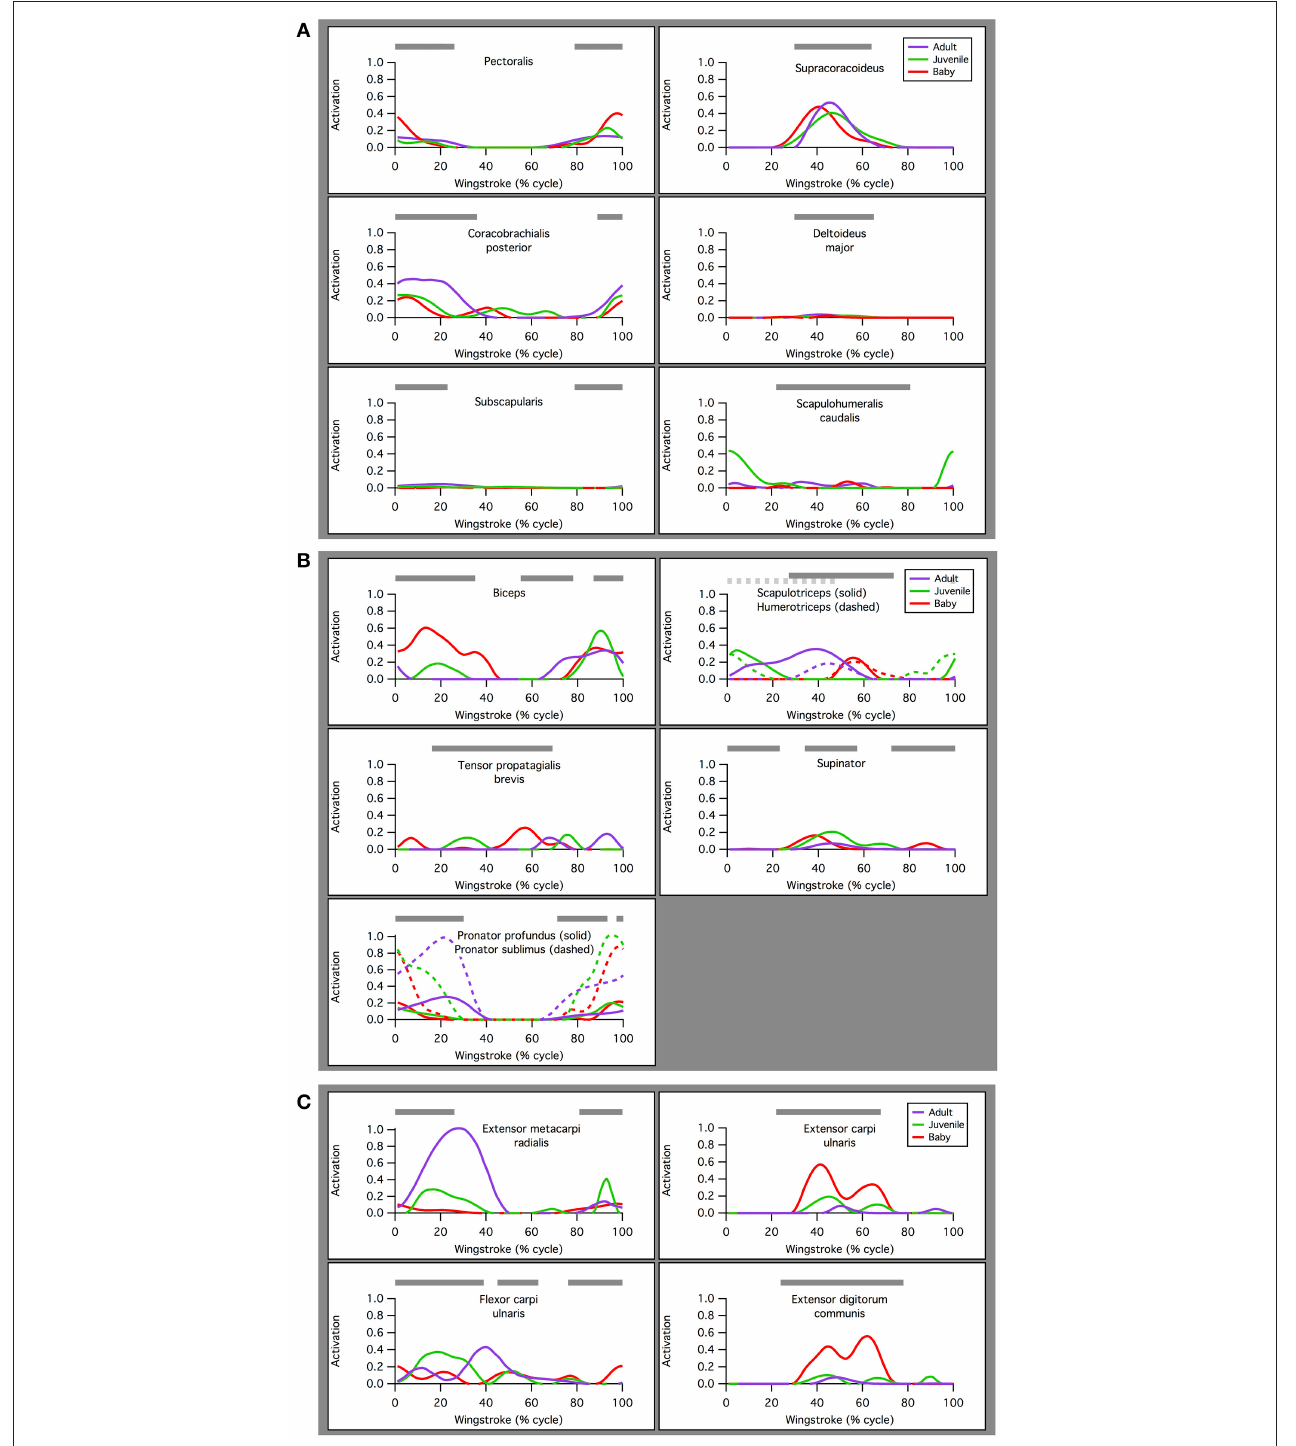
FIGURE 4 | Muscle activations. Simulated patterns of muscle activation during wing-assisted incline running on 65 ◦ inclines (red, green, and purple lines) are broadly similar to the timing of muscle activity during ascending flight in pigeons (gray bars, from Dial, 1992a); for explanation of exceptions, see text. Here, the upstroke-downstroke transition is defined as the point at which the tip of the manus begins moving downward, and the downstroke-upstroke transition as the point at which the tip of the manus begins moving upward. (A) Muscles acting at the shoulder joint. (B) Muscles acting at the elbow joint. (C) Muscles acting at the wrist joint.